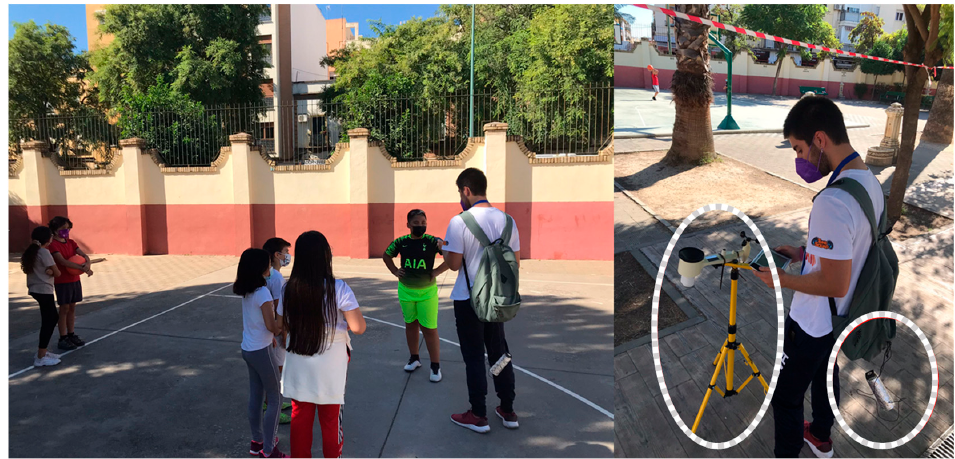
Figure 10. Example of a survey session.